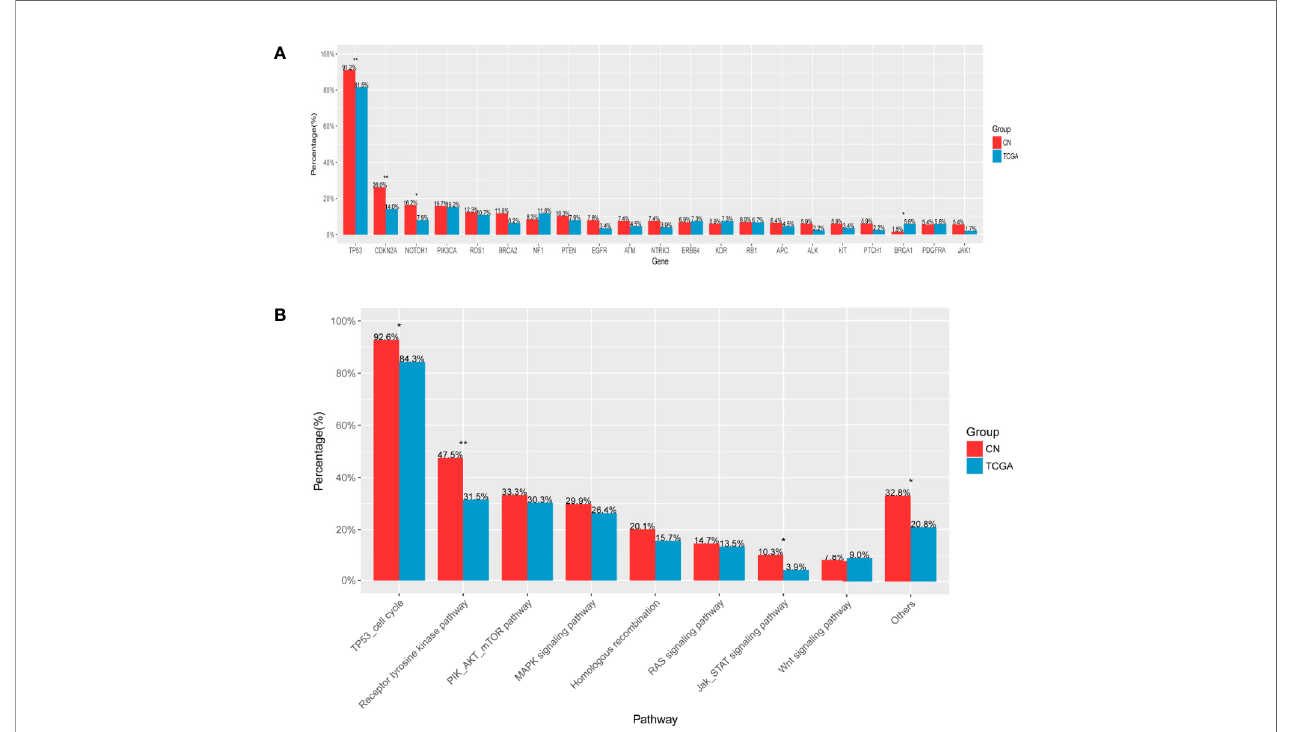
FIGURE 5 | Comparative mutational analysis of LUSC in our cohort and TCGA cohort (A) . X-axis denotes gene, Y-axis, patient frequency (B) . X-axis denotes signaling pathway, Y-axis, patient frequency. *p < 0.05, **p <